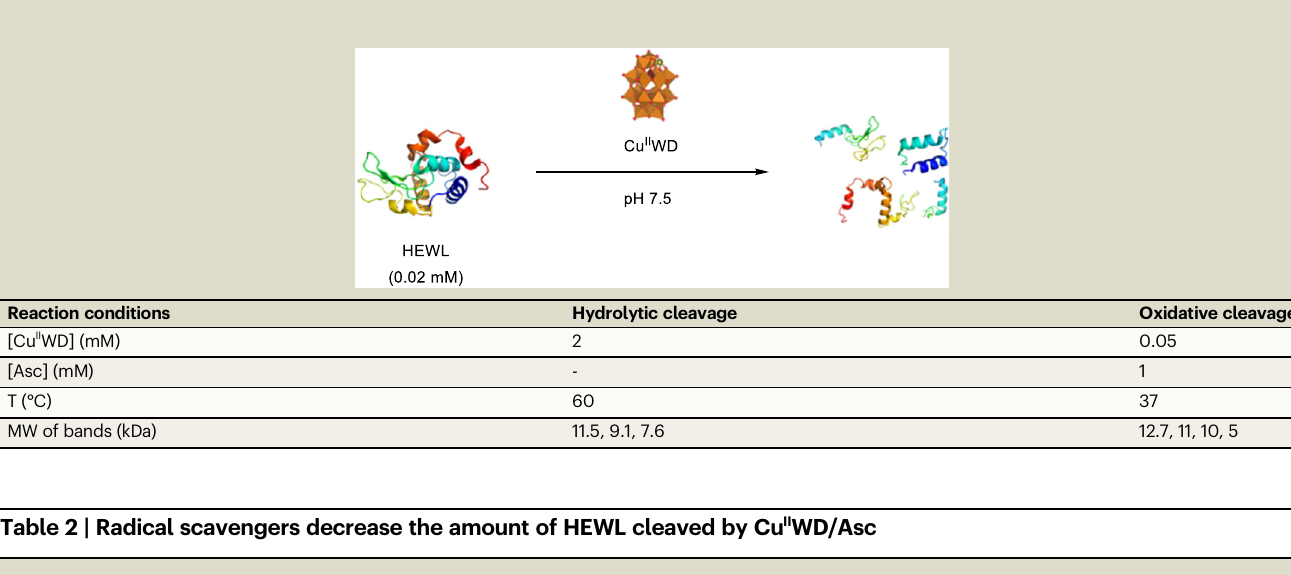
Table 1 | Hydrolytic and oxidative reaction conditions afford distinct cleavage of HEWL